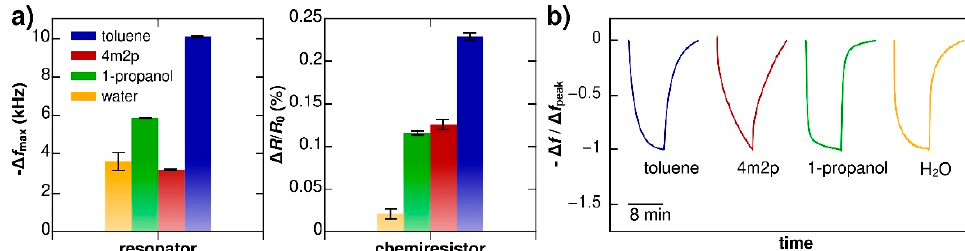
Figure 2. ( a ) Frequency shift responses of a GNP membrane resonator to exposures to different VOCs (8 min exposure, 10,000 ppm, 20 mbar total pressure, N 2 atmosphere) and resistive responses of another section of the same GNP composite film to the exposures; ( b ) Response kinetics of the GNP membrane resonator under transient exposure to the different VOCs